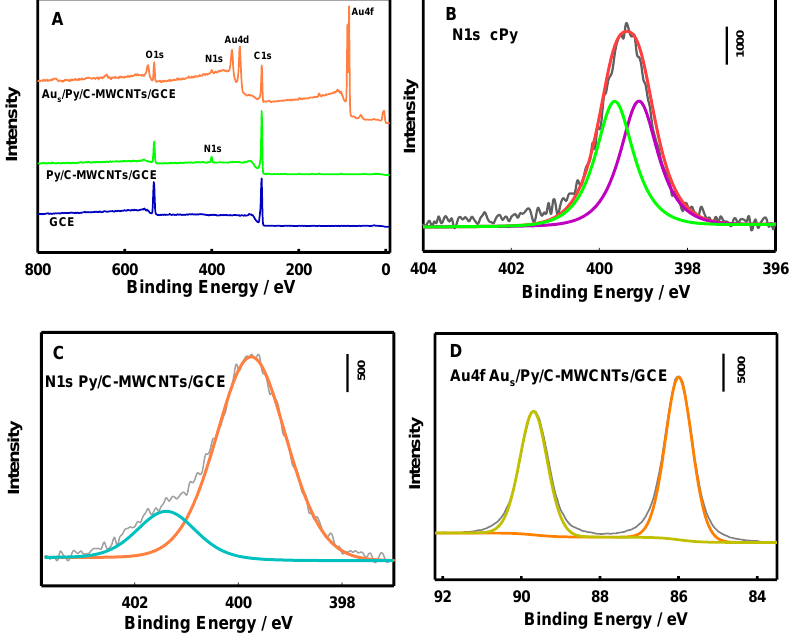
Figure 2. ( A ) XPS survey of GCE, Py/C-MWCNTs/GCE, and Au s /Py/C-MWCNTs/GCE; ( B ) high-resolution N1s region of Py/GCE; ( C ) high-resolution N1s region of Py/C-MWCNTs/GCE; ( D ) high-resolution Au4f region of Au s /Py/C-MWCNTs/GCE.